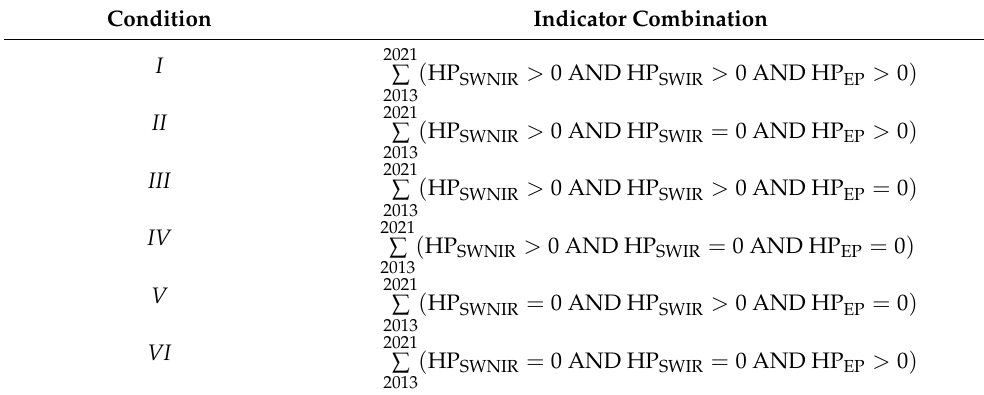
Table 1. Indicator combination contributing to the HP value.